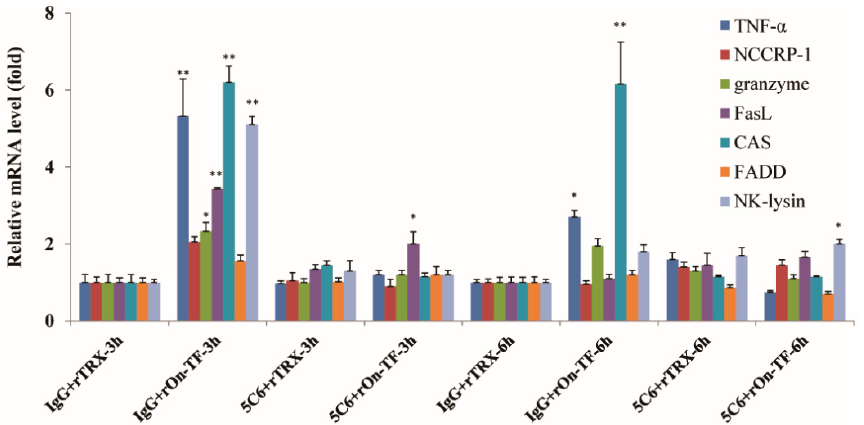
Figure 6. Expression of NCC-related genes after rOn-TF stimulation by qRT-PCR. The transcriptional level of NCC-related genes in the IgG+rTRX group at 3 and 6 h was set as 1. All values are the mean ± SD, n = 3. Significant difference is indicated by asterisks: * 0.05 > p > 0.01, ** p < 0.01.